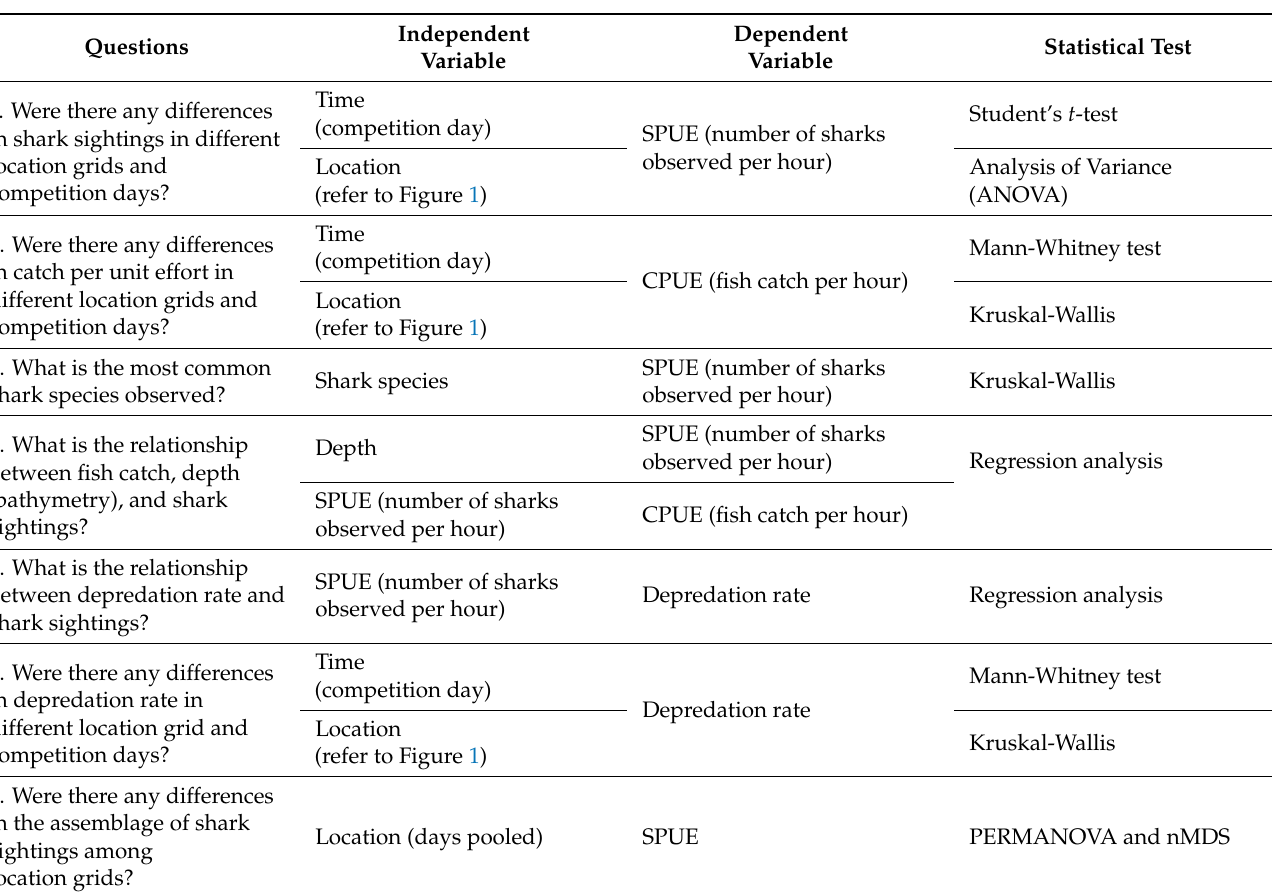
Table 1. Statistical analysis performed to compare different variables. SPUE (shark per unit ef- fort), ANOVA (Analysis of Variance), CPUE (catch per unit effort), PERMANOVA (permutational multivariate analysis of variance), nMDS (non-metric Multidimensional